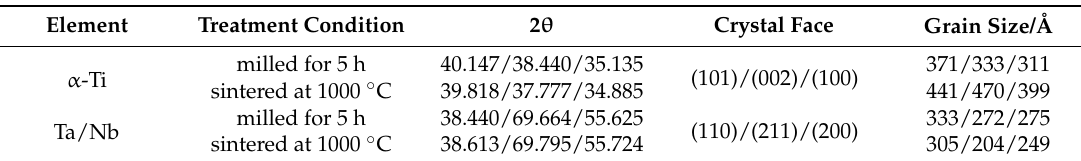
Table 4. Grain size of some phases in the 0.5-GNFs nanocomposite calculated by XRD Pattern Processing and Identification